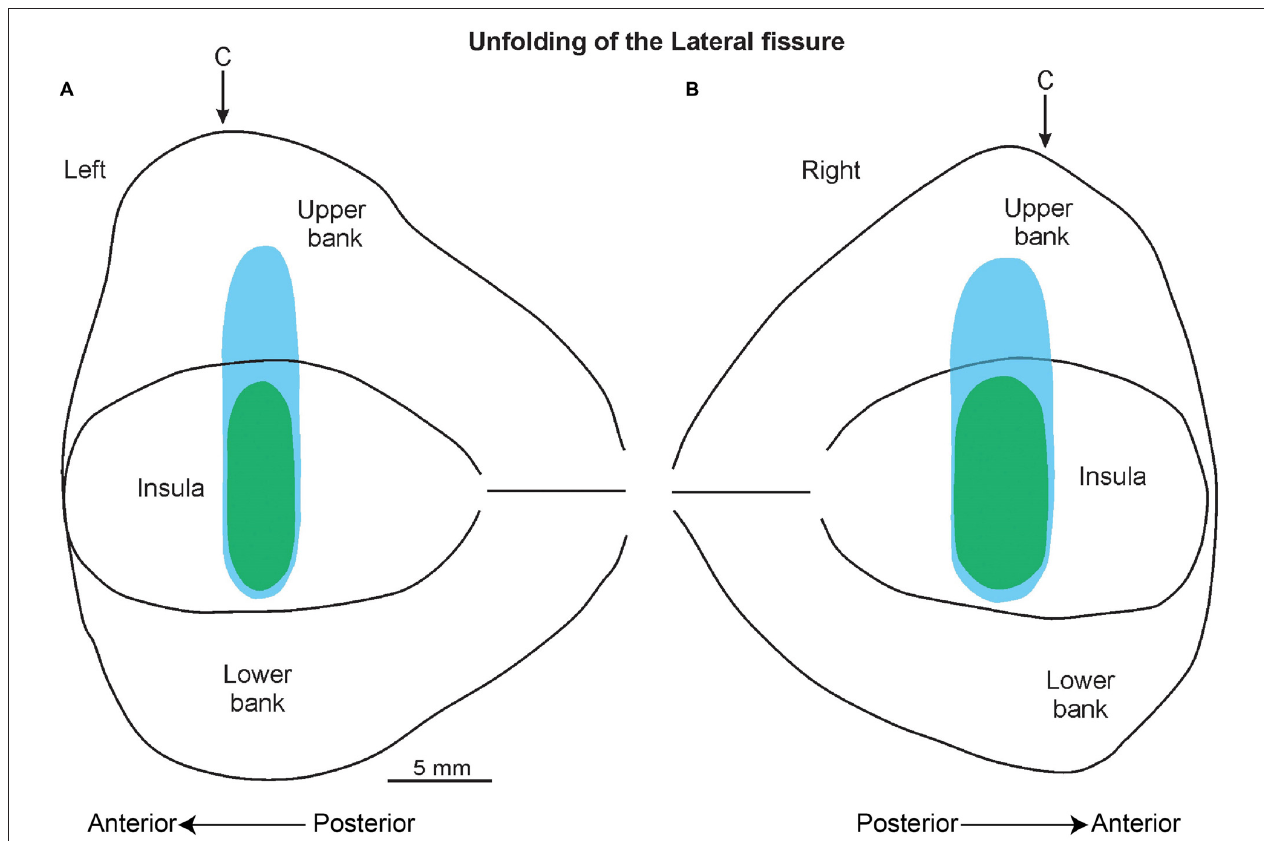
FIGURE 5 | A 2D reconstruction of the lateral fissure of the left (A) and right (B) hemisphere, aligned to the middle of the insula; the continuous lines mark the lips of the sulcus, the border of the insula with the upper and lower bank of the sulcus, and the fundus. The blue area indicates the recorded region related to the SU neurons, while the green area indicates the recorded area of the SS neurons. The arrow marks the rostral-most level of the central sulcus